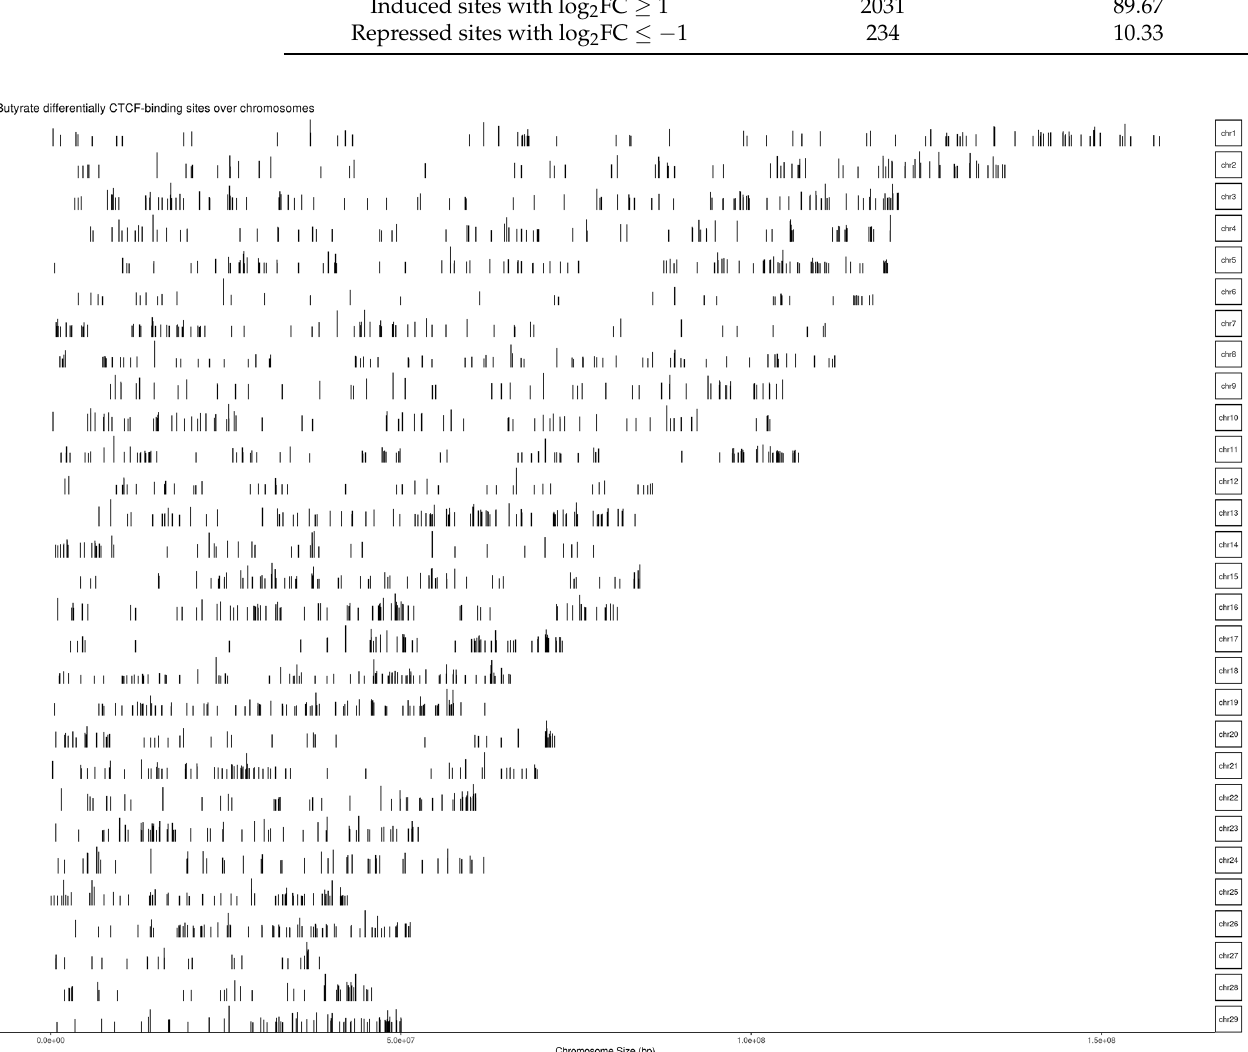
Figure 2. Chromosomal distribution of 2265 butyrate differentially CTCF-binding sites (considering bovine chromosomes 1–29).